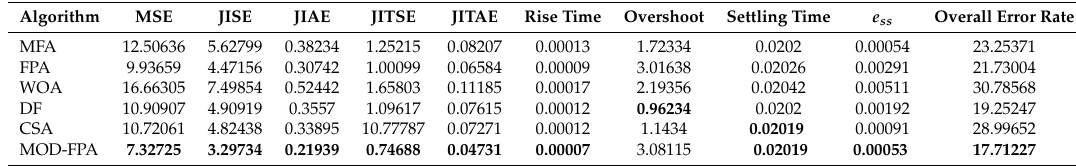
Table 10. Performance analysis, Case 1.